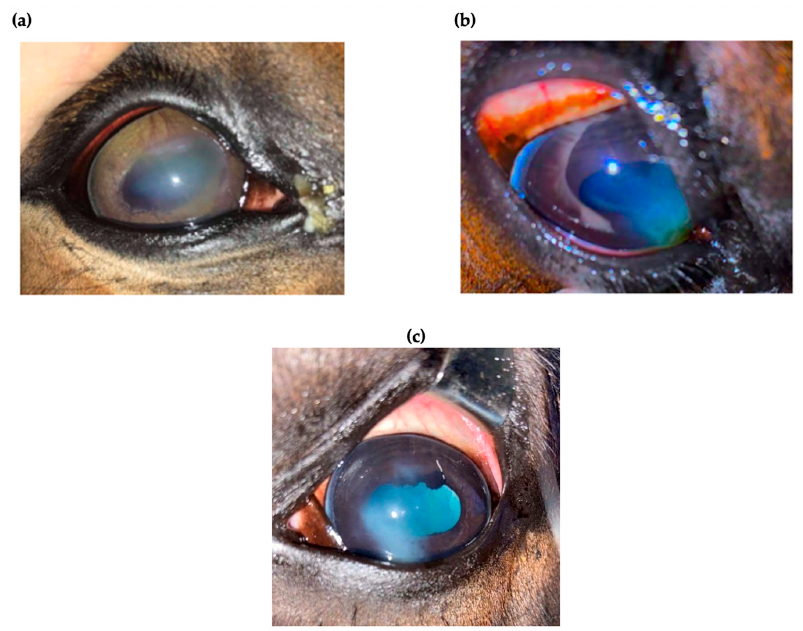
Figure 6. Images represent the two cases of immune-mediated keratitis (IMMK). ( a ) Mucopurulent discharge, mild conjunctival hyperemia, superficial vascularization corneal opacity with cellular infiltration within the mid stroma of the cornea. ( b ) Conjunctival hyperemia, mild mucus discharge and cellular infiltration within the superficial and mid stroma of the cornea. ( c ) Mild conjunctival hyperaemia, corneal edema, and cellular infiltration within the mid stroma of the cornea.